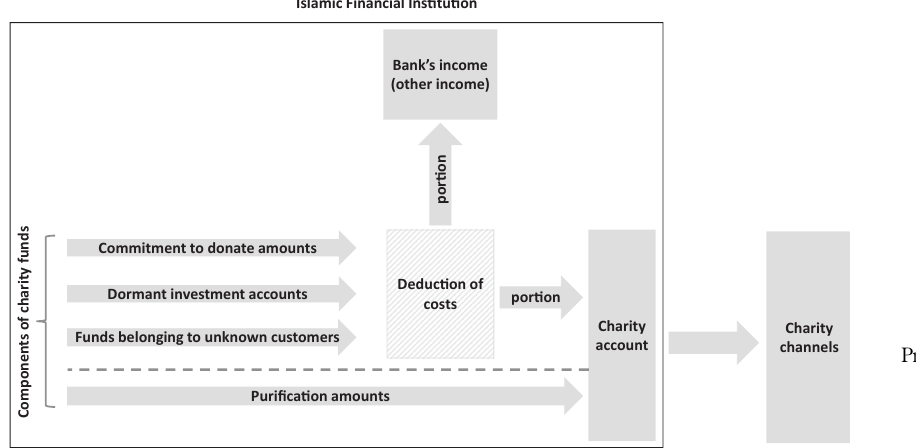
Figure 1. Process flow for the charity account in Islamic